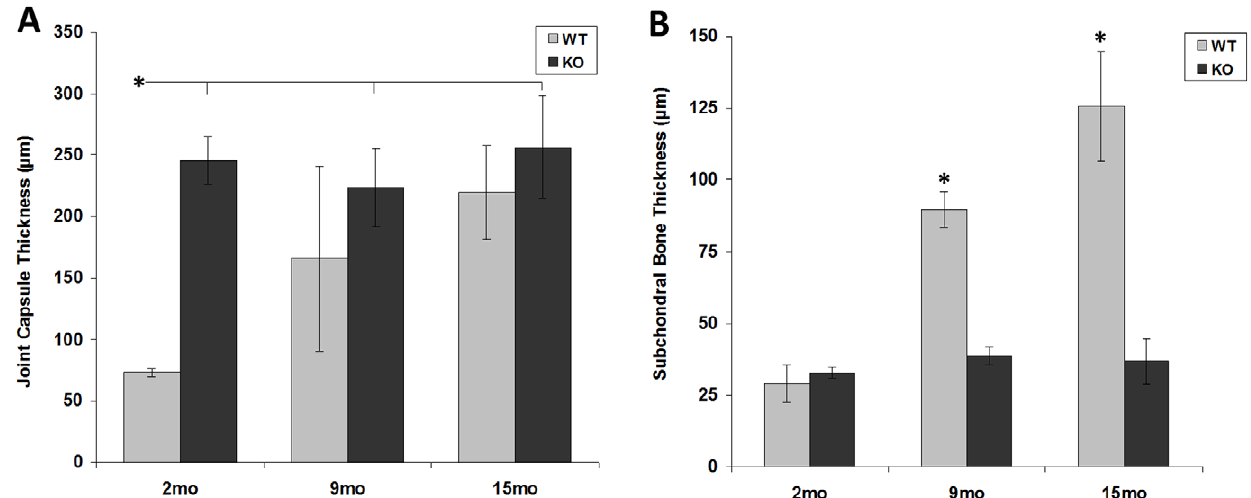
Figure 5. Effects of genotype on the joint capsule and subchondral bone. Joint capsule thickness on the medial side was high in Col6a1 2 / 2 mice from the youngest age but almost universally low in wild-type mice until the oldest age (A). Subchondral bone thickness, in contrast, shows that Col6a1 2 / 2 bone fails to thicken with age, unlike the wild-type bone (B). Bars are mean 6 SEM. Starred bars with no connecting lines are different from all other bars including each other. Starred bar connected by notches on horizontal line to multiple bars is different from those values. * p , 0.05,